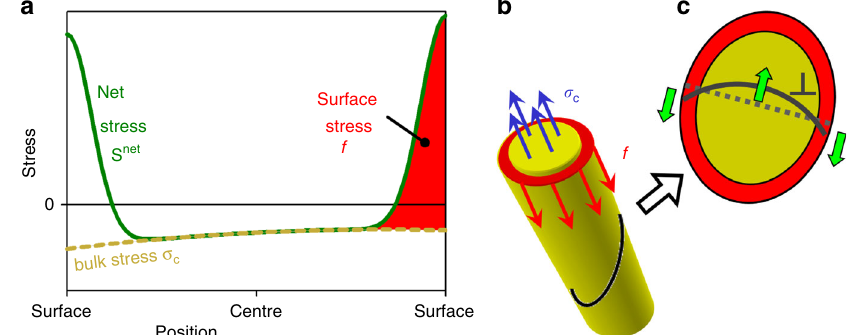
Fig. 1 Stress in a nanowire and its impact on dislocation glide. Schematic representations. a Green line, stress pro fi le along a linear section through the wire. The actual stress S net may be decomposed into bulk stress σ C (yellow dotted line) and surface stress f (red shaded area). b Balance of force on a normal cross-section. Surface regions (red) experience tensile stress, which is represented by the surface stress and which is compensated by an oppositely- signed surface-induced stress σ C in the bulk (blue). c Dislocation (gray line) on an inclined cross-section. Shear components of stresses from a give rise to Peach – Köhler forces that mutually